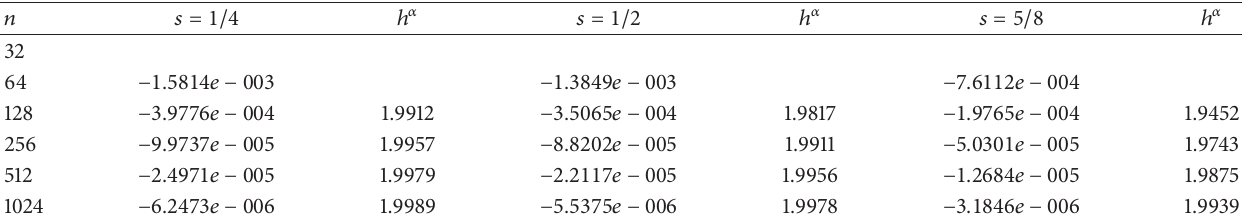
Table 4: A posteriori error estimate of the mod-trapezoidal rule.